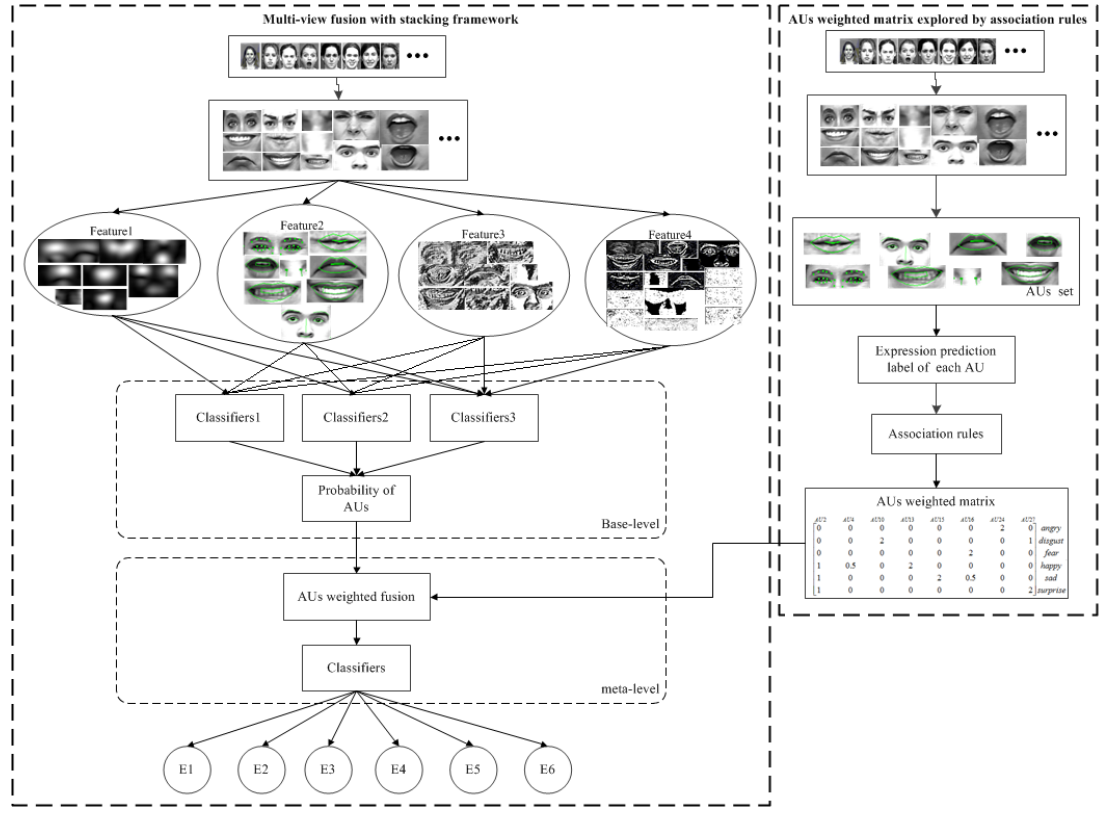
Figure 2. The architecture for our proposed fusion-based expression recognition approach.(Note: we denote the outputs, viz. the six basic expressions—angry, disgust, fear, happy, sad, surprise—as E1, E2, E3, E4, E5, E6 separately.)